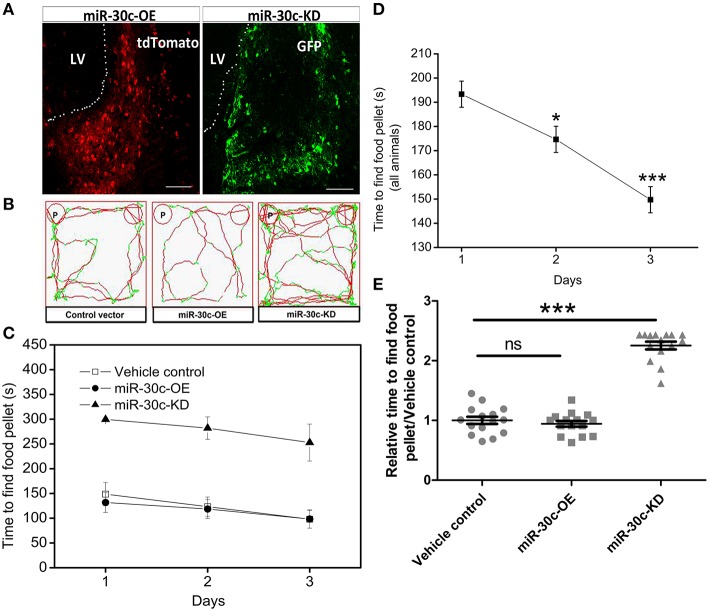
Effect of miR-30c on olfactory sensitivity. (A) Representative images of miR-30c-OE and miR-30c-KD expression in the SVZ 2 weeks after stereotaxic injection. Scale bar, 50 μm. (B) Trajectories of mice in finding food pellets detected by real-time infrared ray video. Red line, speed of mice > 10 cm/s and green line, speed of mice < 2 cm/s; p, food pellet location. (C) Time to find food pellets with days. (D) Time effect on olfactory sensitivity of all animals (results derived from two-way ANOVA analysis, time and groups as two main factors). *p < 0.05, ***p < 0.001 determined by Bonferroni multiple comparison tests. (E) miR-30c effect on olfactory sensitivity in finding food pellets, ns, not significant; ***p < 0.001 determined by two-way ANOVA analysis followed by Bonferroni multiple comparison tests. miR-30c-OE, miR-30c overexpression; miR-30c-KD, miR-30c knockdown; LV, lateral ventricle;
n = 15 mice, five mice/group.